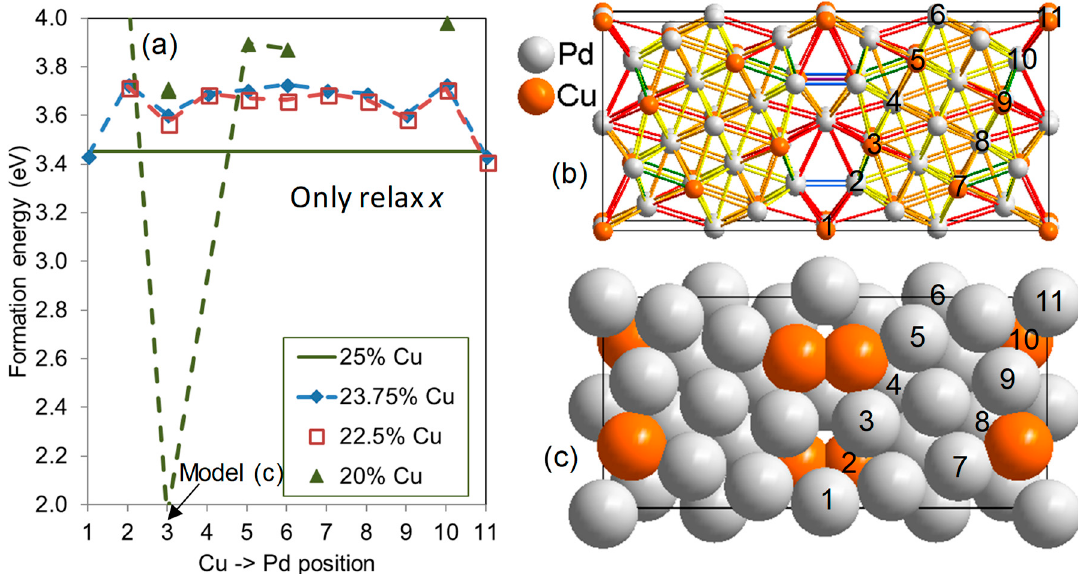
Figure 7. ( a ) The formation energy E form of binary Pd 1 − n Cu n alloys with four levels of the Cu concentration n in a ∑ 5(210) GB model. The volume of all models is fully relaxed. The solid green line designating 25% Cu corresponds to the formation energy of perfectly ordered Pd 3 Cu as shown in ( b ). Lines between atoms are rainbow colored according to the relaxed interatomic distance; violet is shortest (<2.4 Å), dark red is longest (>2.9 Å), and orange is similar to that of density functional theory (DFT) relaxed bulk Pd 3 Cu (2.7 Å). Models with lower Cu content than 25% are generated by substituting Cu with Pd at various positions in the model, defined by the numbers in ( b , c ). The energy is drawn as a function of these positions. See the text for details about the formation energies plotted in ( a ).